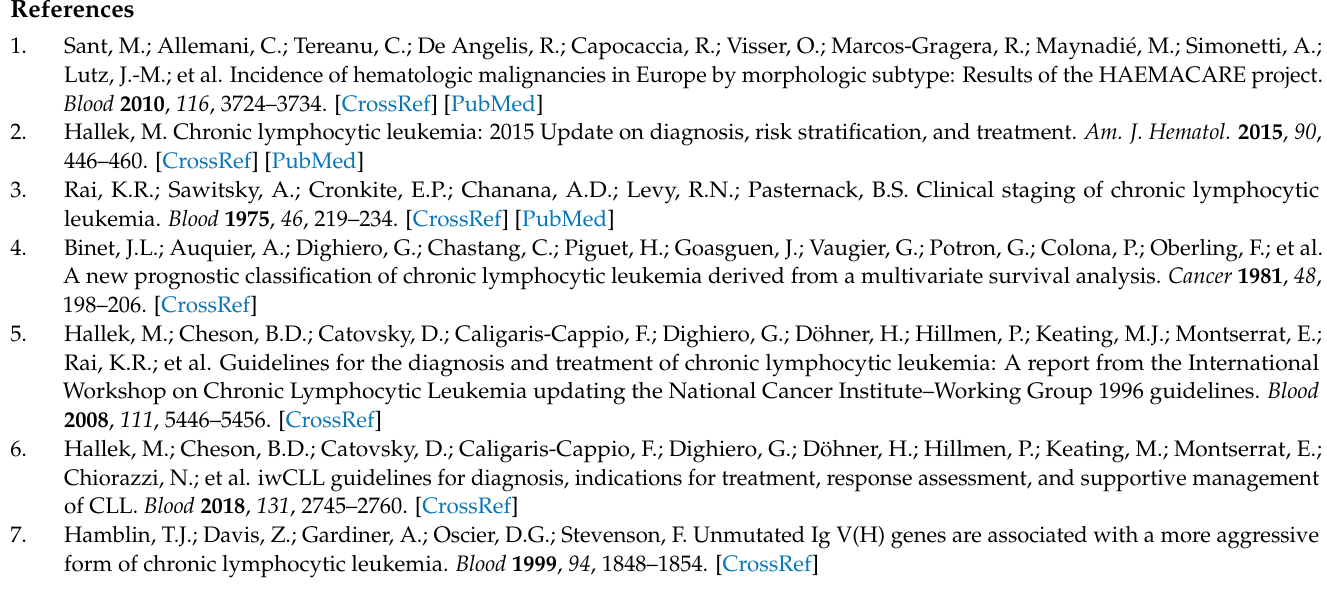
Table S2: Five-year overall survival of the CLL-IPI categories versus our series of CLL